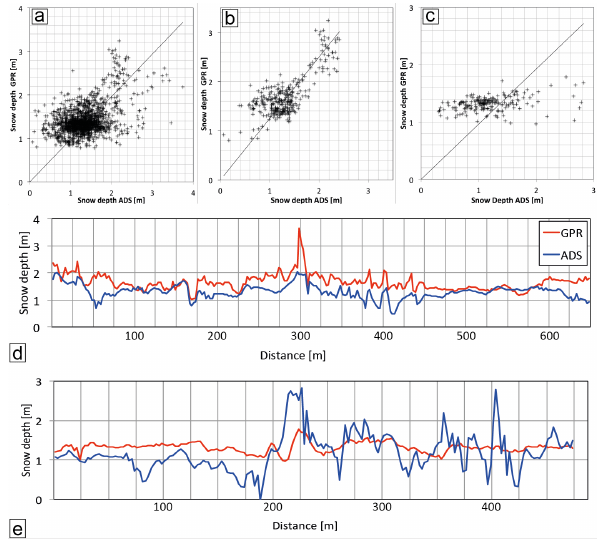
Figure 7. Correlation of the ADS snow depth to the GPR snow depth for all 1522 points ( a , cor e = 0 . 45), segment number 1 with 296 points and a larger value range ( b , cor e = 0 . 77), and segment number 5 with 191 points and a low value range in the GPR data ( c , cor e = 0 . 34).